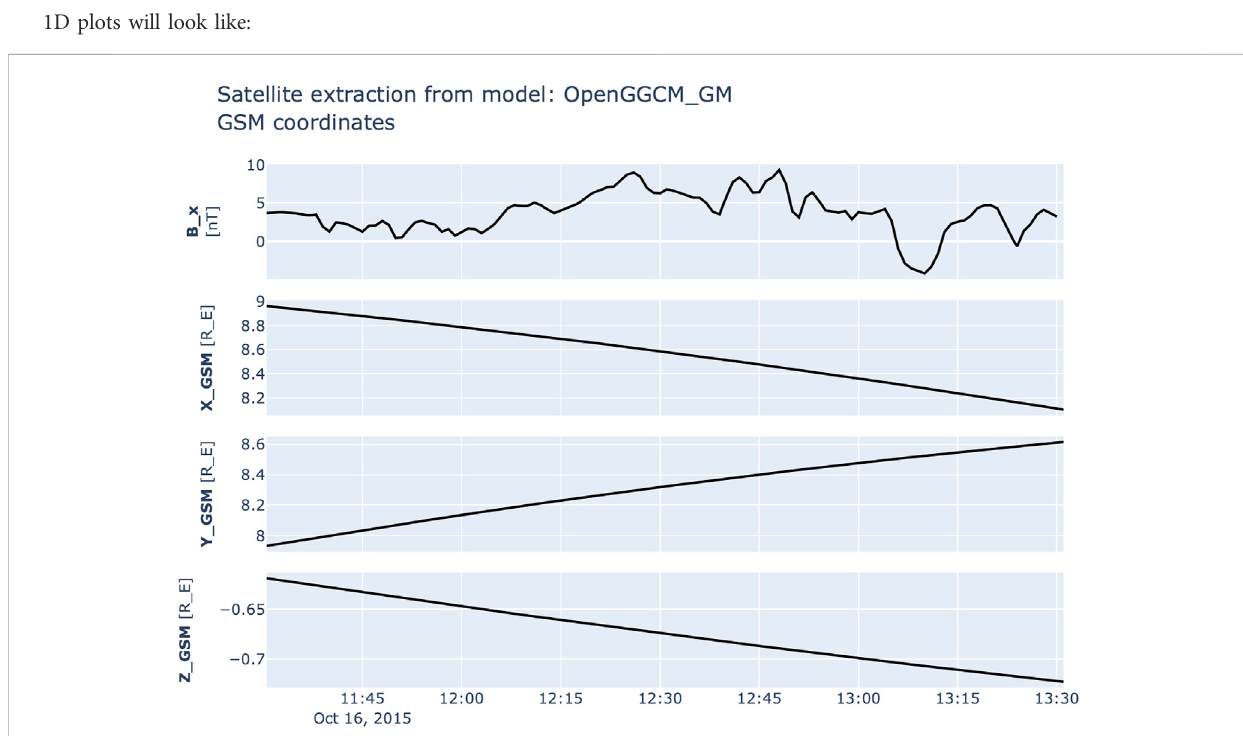
FIGURE 6 A screenshot of a 1D plot produced by the Kamodo fl